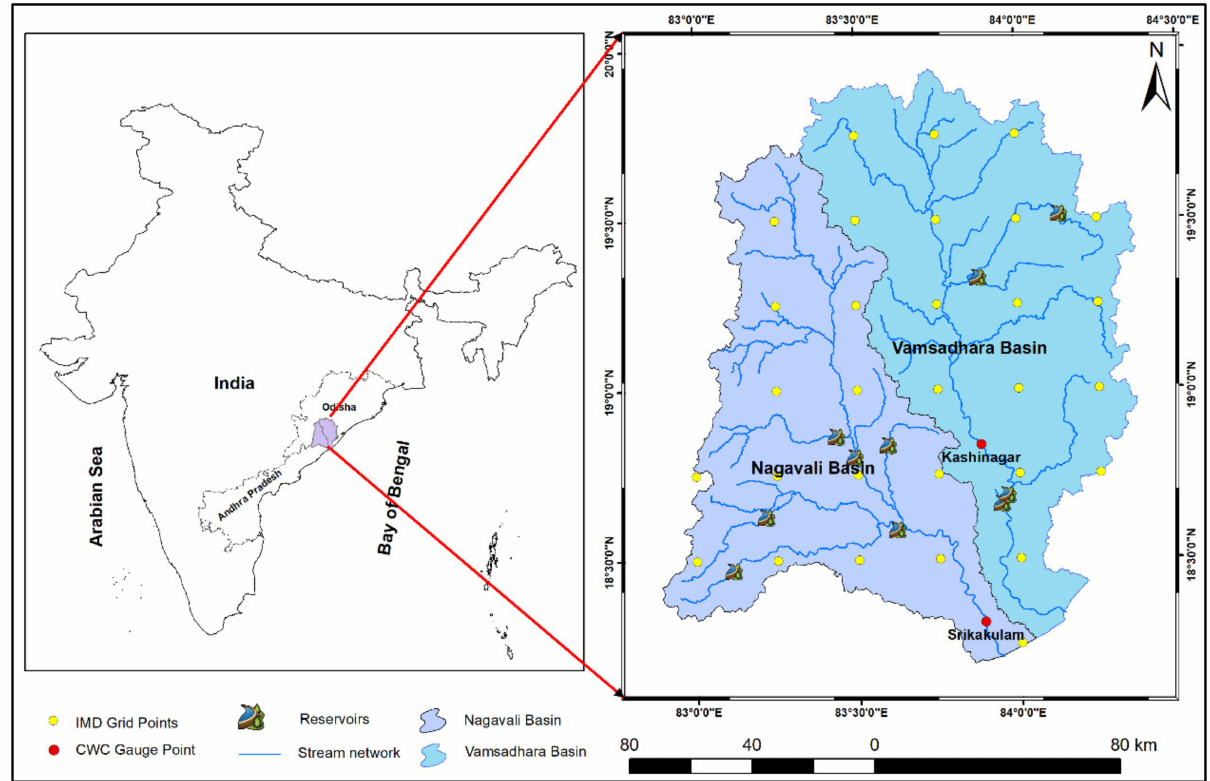
Figure 1. Map of the Nagavali and Vamsadhara river